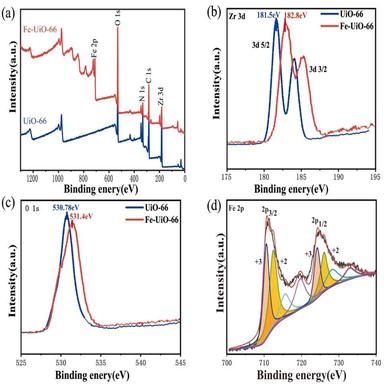
XPS spectra of UiO-66 and Fe-UiO-66: (a) survey scan, (b) Zr 3d, (c) O 1s and (d) Fe 2p XPS in Fe-UiO-66.